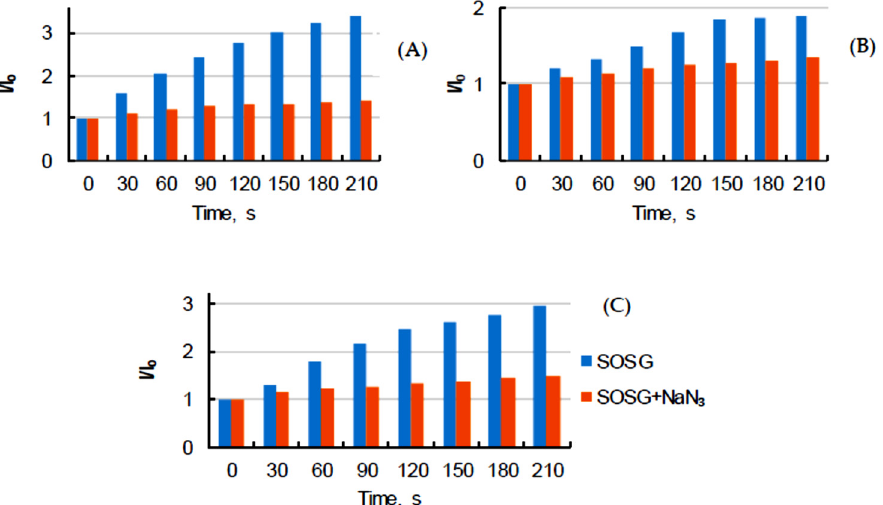
Figure 5. Comparison of fluorescence emission intensity of Singlet Oxygen Sensor Green (SOSG) and SOSG + NaN 3 in D 2 O for 1 O 2 detection after excitation of PpIX ( A ), PPa ( B ), and PF ( C ) ( λ exc = 400 nm for PS and 495 nm for SOSG) ( c = 3.1 μ M). Table 5. Φ ∆ of PpIX, PPa, and PF in different solvents at room temperature ( c = 1.87 μ M). Table 6. 1 O 2 lifetime of PpIX, PPa, and PF in different solvents at room temperature ( c = 1.87 µ M).